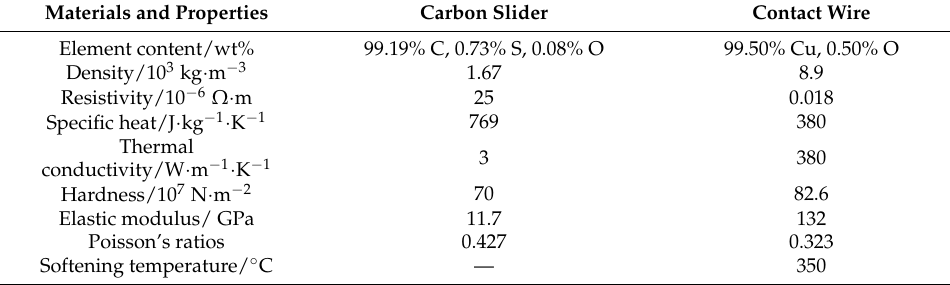
Table 2. Major element and physical properties of the test